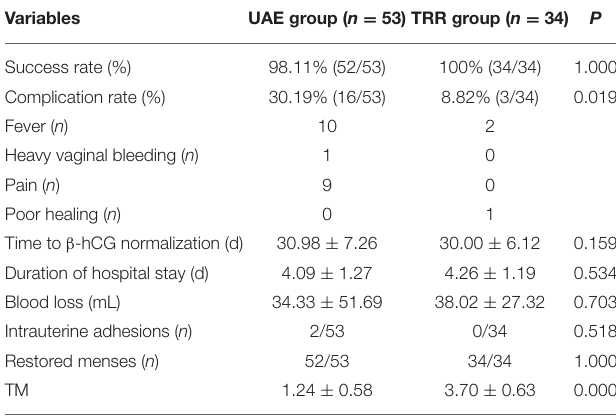
TABLE 2 | Outcomes of patients with CSP treated with UAE combined with curettage or TRR.